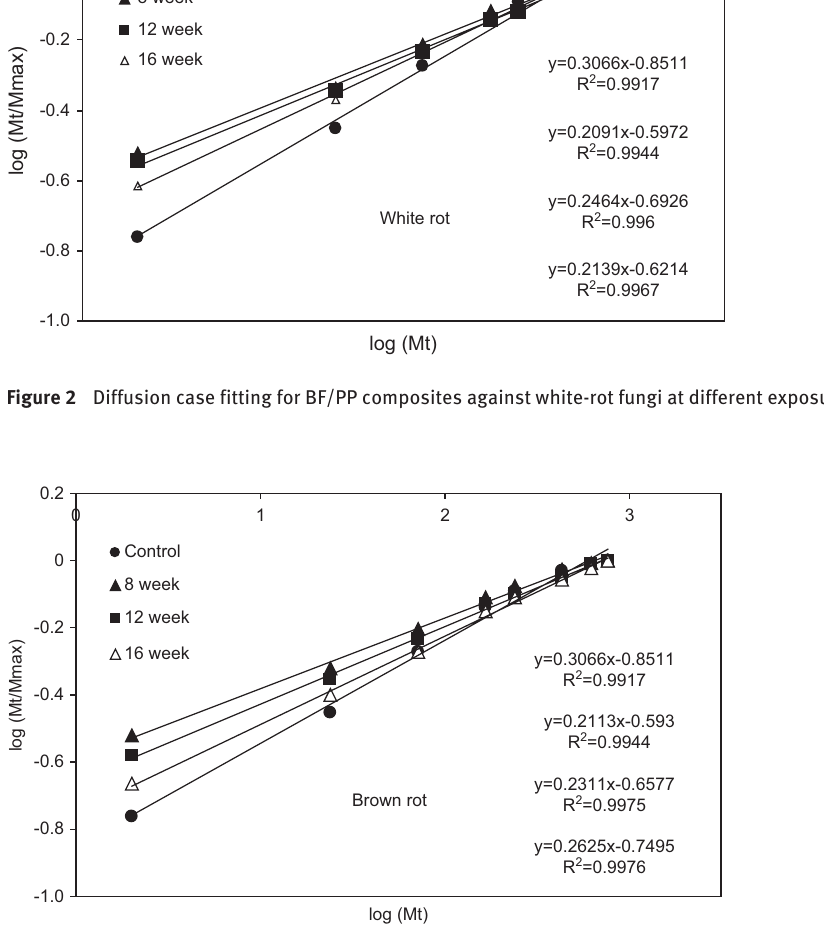
Figure 3 Diffusion case fitting for BF/PP composites against brown-rot fungi at different exposure times.